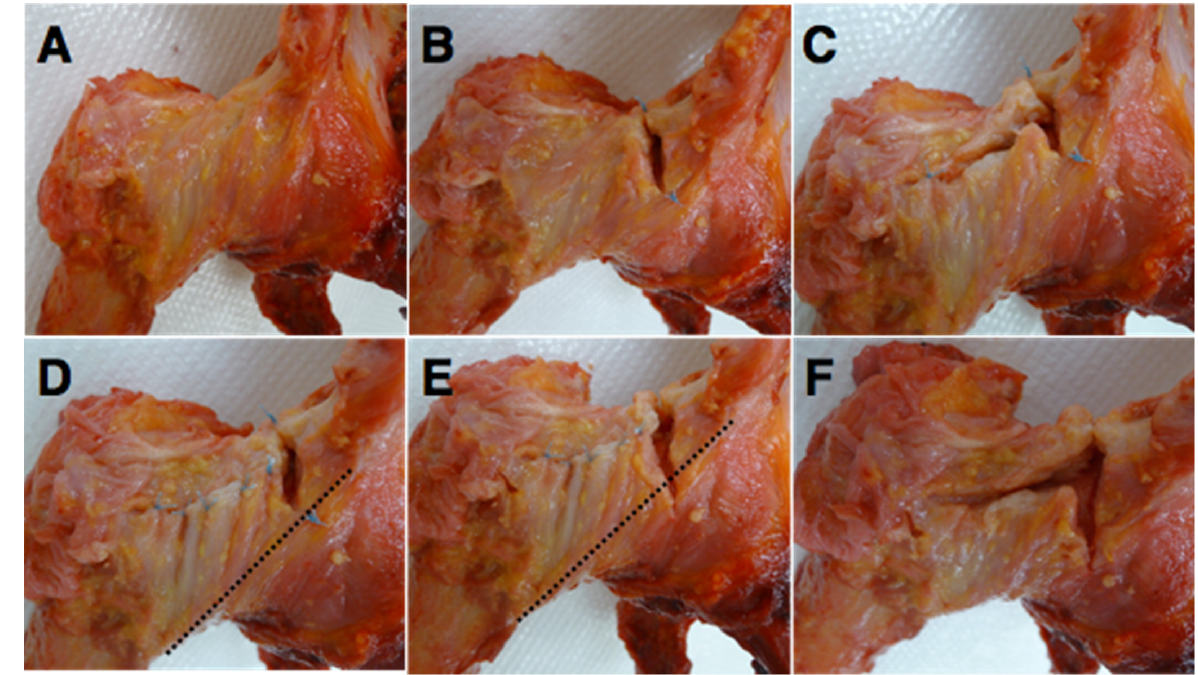
Figure 2. The condition of the capsule tested. ( A ). Intact capsule. ( B ). Interportal capsulotomy. ( C ). T-capsulotomy. ( D ). Repair to interportal capsulotomy. ( E ). Entire iliofemoral ligament (IFL) resec- tion. ( F ). IFL and zona orbicularis (ZO) resection. The dotted line indicates the lower margin of IFL.